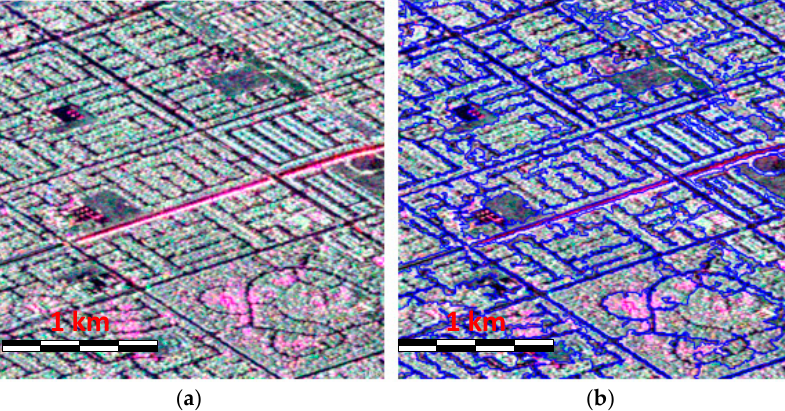
Figure 3. Illustration of the superpixel generation using AIRSAR C band data: ( a ) PolSAR image with Pauli color-coding (red: |HH − VV|; green: |HV|; blue: |HH+VV|), and ( b ) superpixel map.